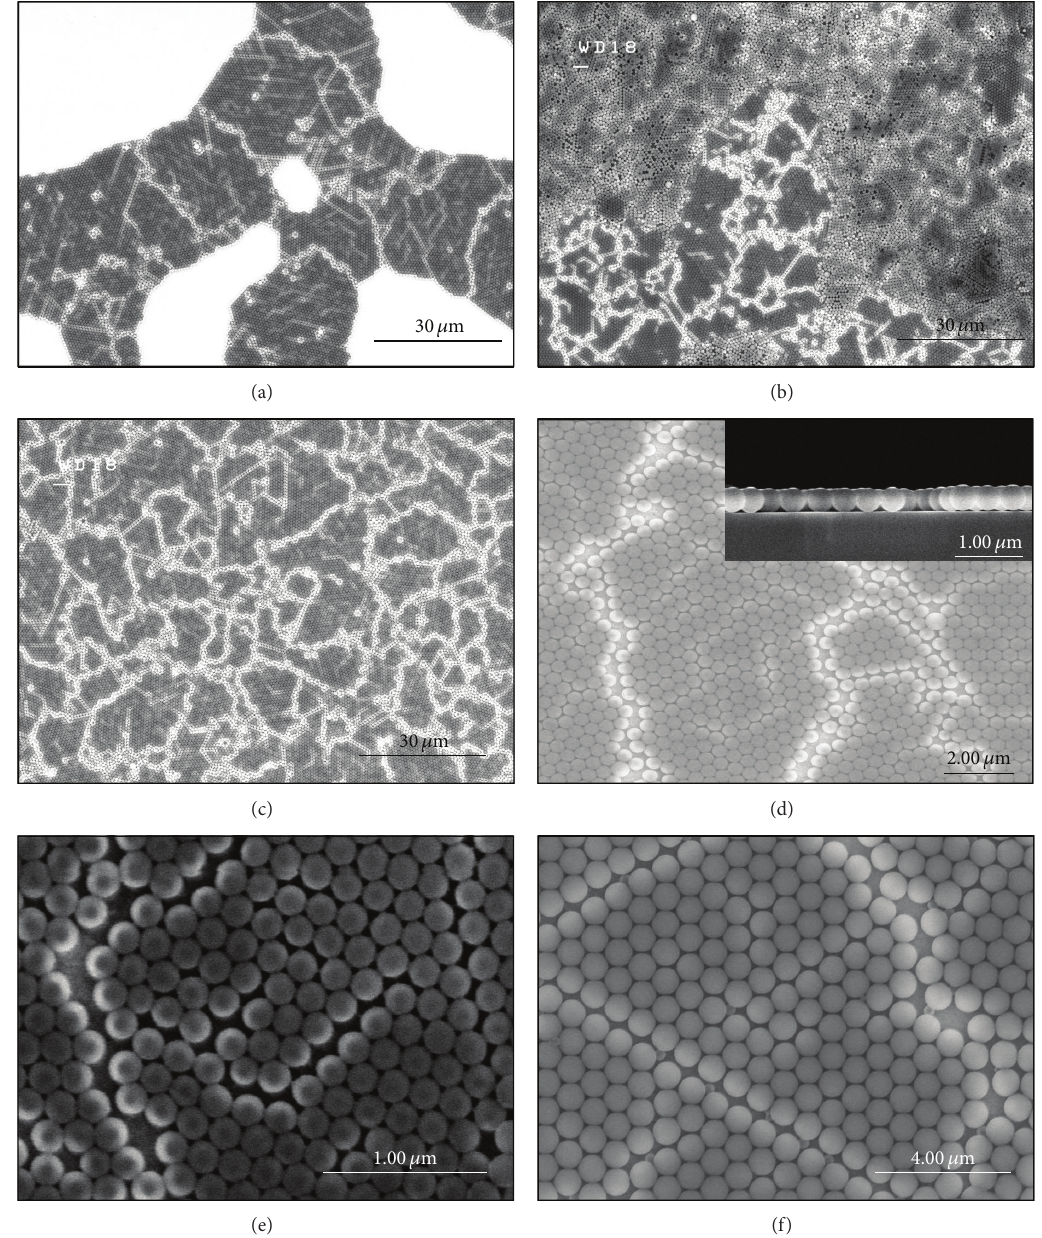
Figure 3: SEM images are for the 400 nm period PS nanospheres distribution at spin speed of (a) 2000 rpm, (b) 500 rpm, and (c) 1100rpm, respectively. (d) The enlarged SEM image is from (c) for a single-monolayered nanosphere array patterns with hexagonal close-packed uniform distribution and the inset image is the corresponding cross-sectional morphology. SEM images are for PS nanospheres arrays with (e) 200 and (f) 800 nm periodicity at spin speed of 2000 and 400rpm,